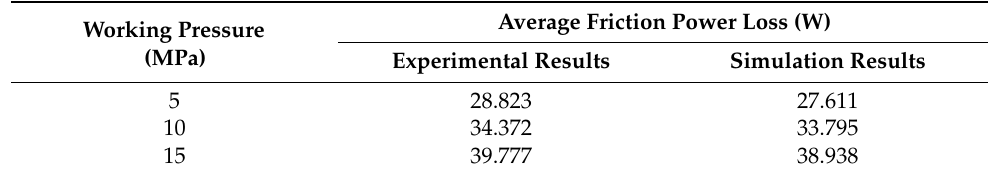
Table 5. Average friction power loss under different working pressure with of shaft speed 1500